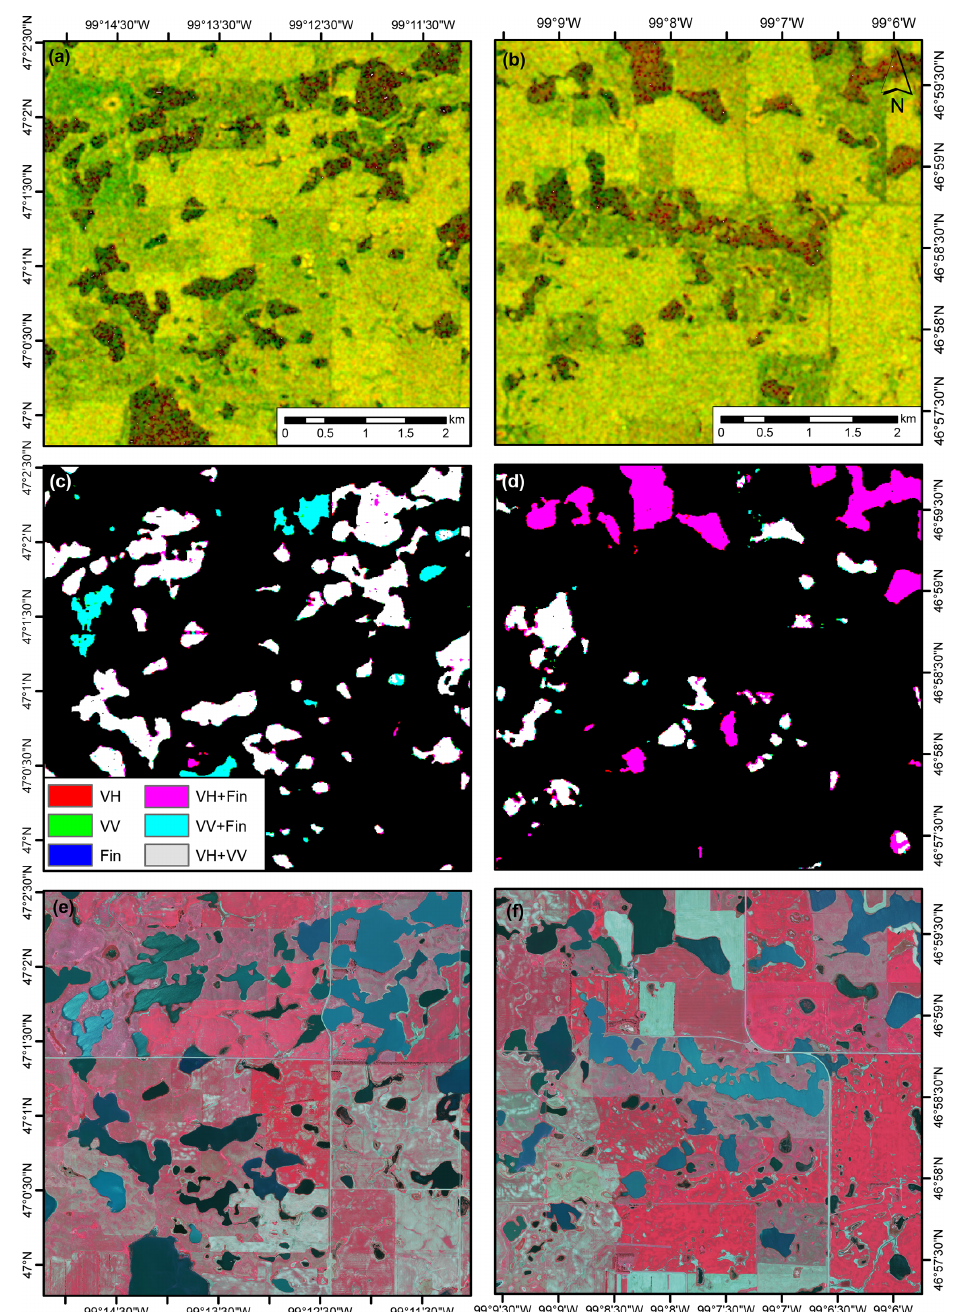
Figure 6. Panels (a) and (b) show colour composites of σ 0 results as RGB composites (R – VH; G – VV; and B – final classification, Fin); and panels (e) and (f) display false-colour composites (R – near-infrared, G – red and B – green) of NAIP imagery acquired on 4 July